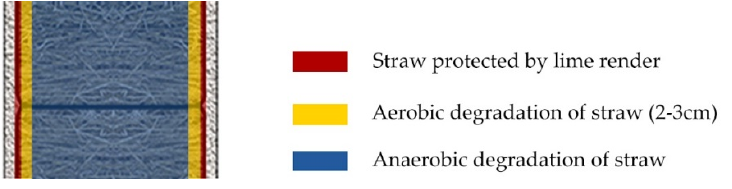
Figure 14. Analysis of straw degradation inside straw bale walls.